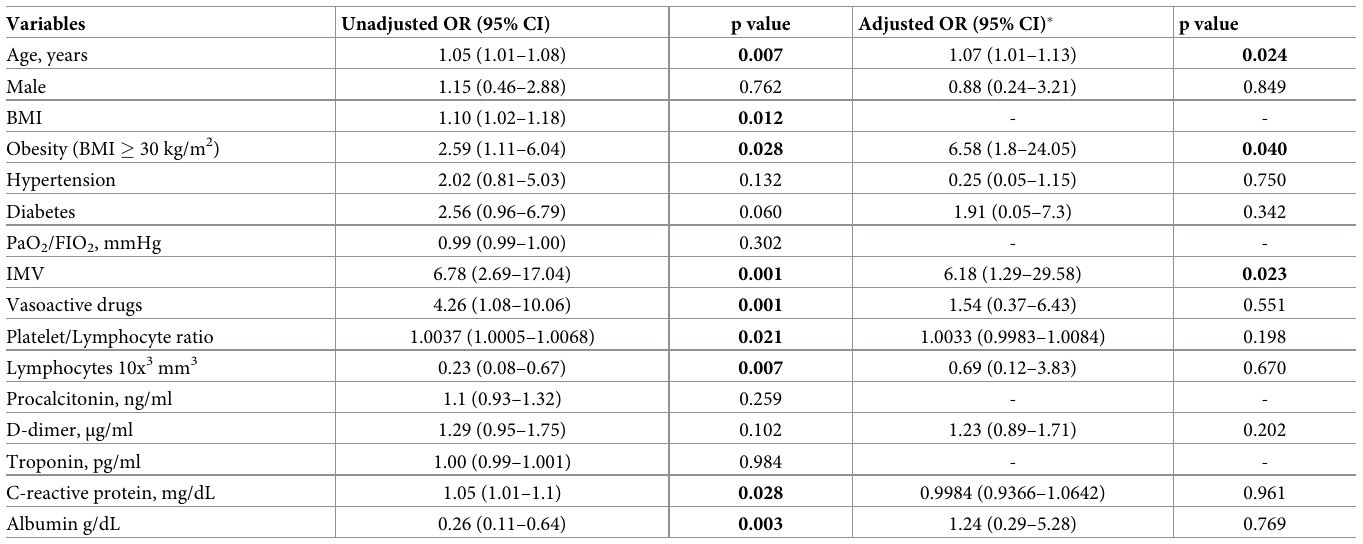
Table 3. Risk factors for acute kidney